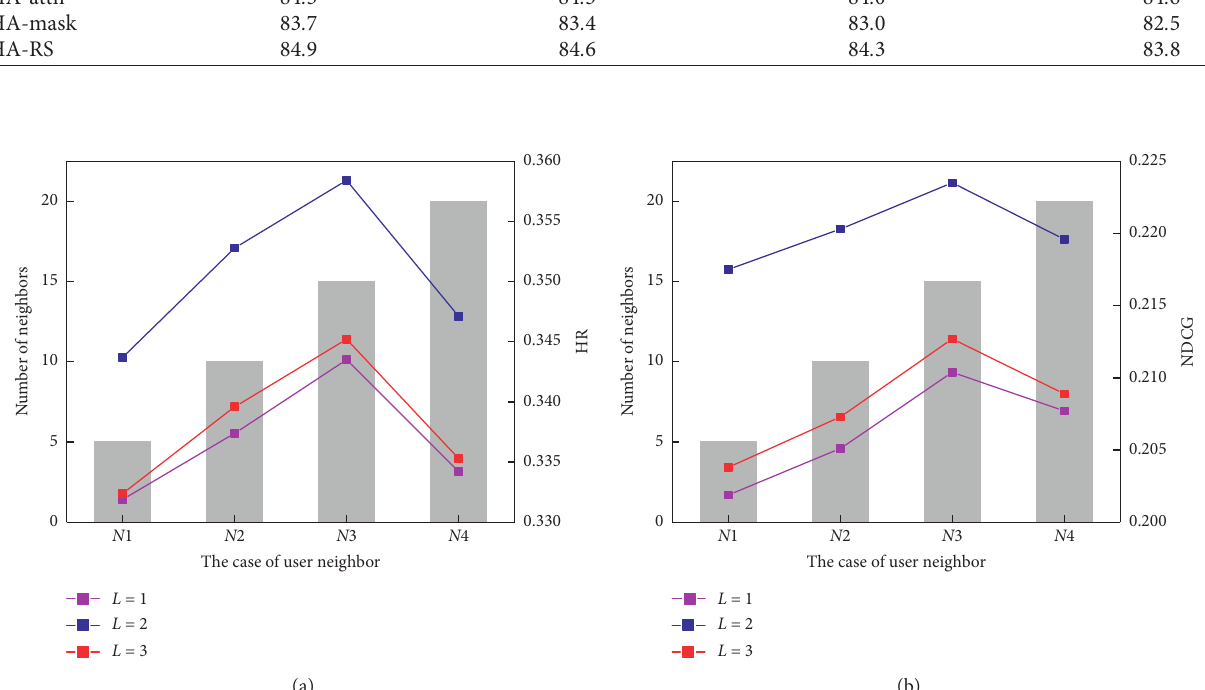
Figure 4: The background histograms indicate the four cases of user neighbor; meanwhile, the lines demonstrate the performance of HR/ NDCG with different layers. (a) Performance of HR. (b) Performance of